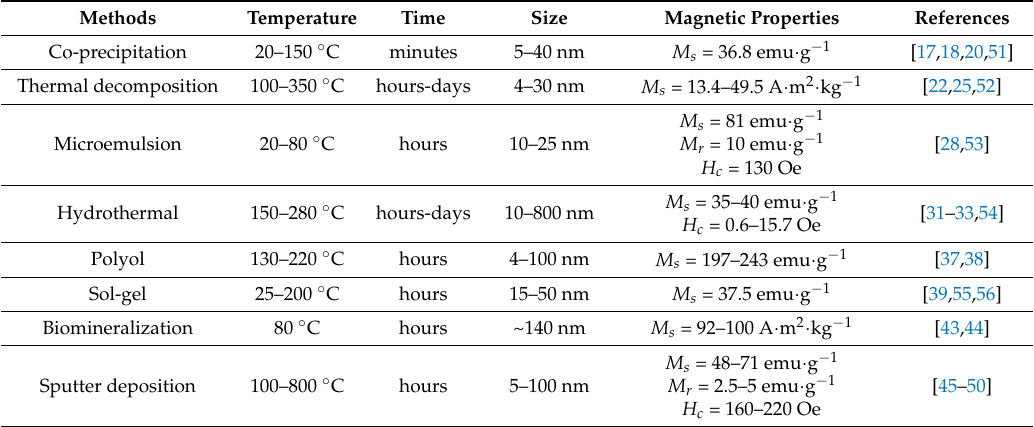
Table 1. IONP synthesis techniques and comparison with respect to their different